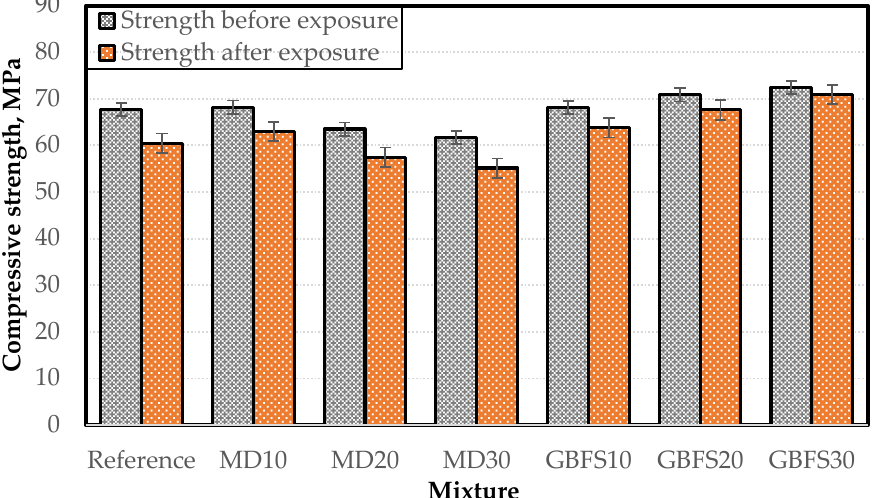
Figure 8. Strength behavior of the mixtures after freeze–thaw cycles.